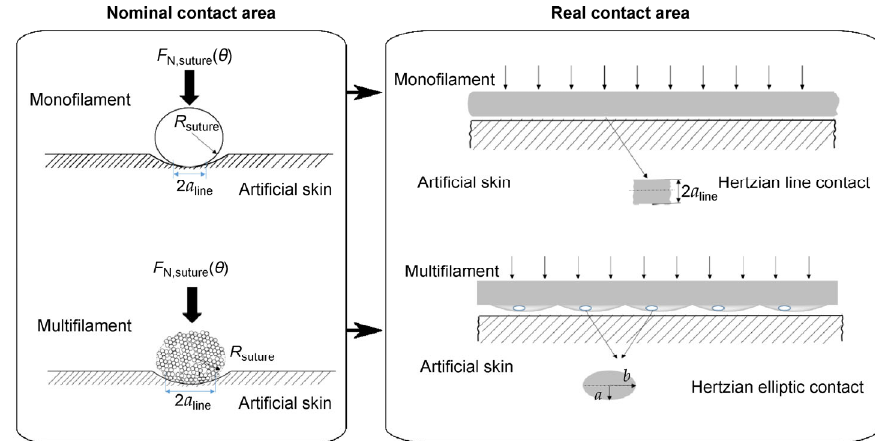
Fig. 4 Nominal and real contact area between a surgical suture and an artificial